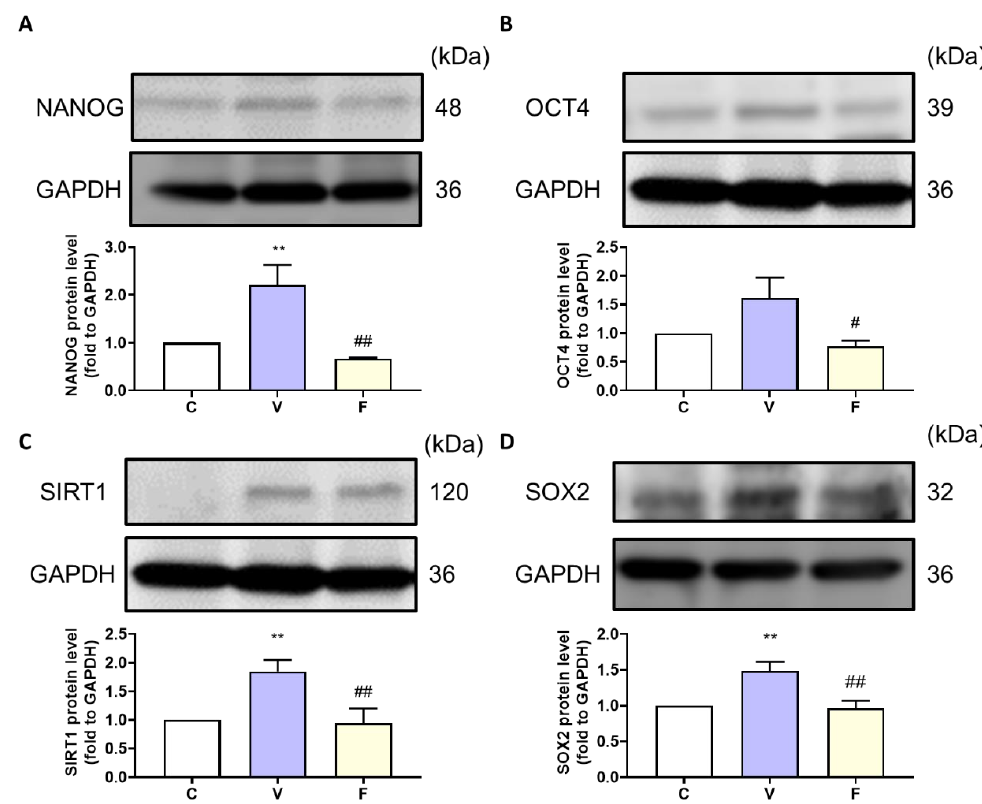
Figure 3. Effect of visfatin on stemness-related protein expression in xenograft tumor tissue. The tumor stemness-related expression of ( A ) NANOG, ( B ) OCT4, ( C ) SIRT1, and ( D ) SOX2 proteins. Data are presented as mean ± SEM. C, control group. V, visfatin-induced group. F, visfatin + FK866 inhibitor group. ** p < 0.01 compared to C. # p < 0.05 and ## p < 0.01 compared to V.